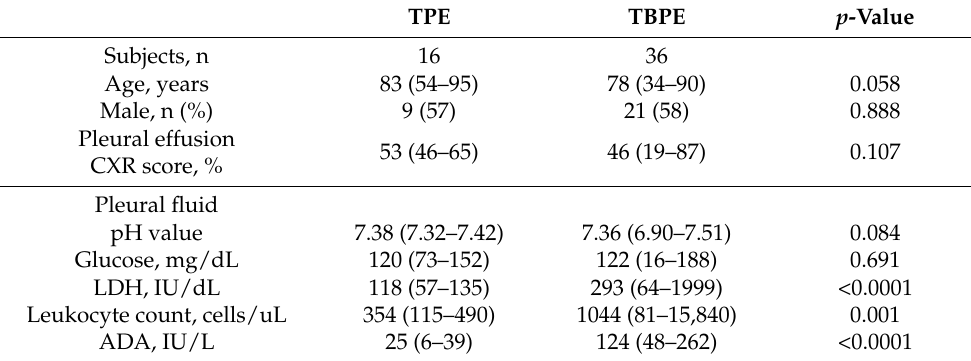
Table 1. Demographics and Pleural Fluid Characteristics